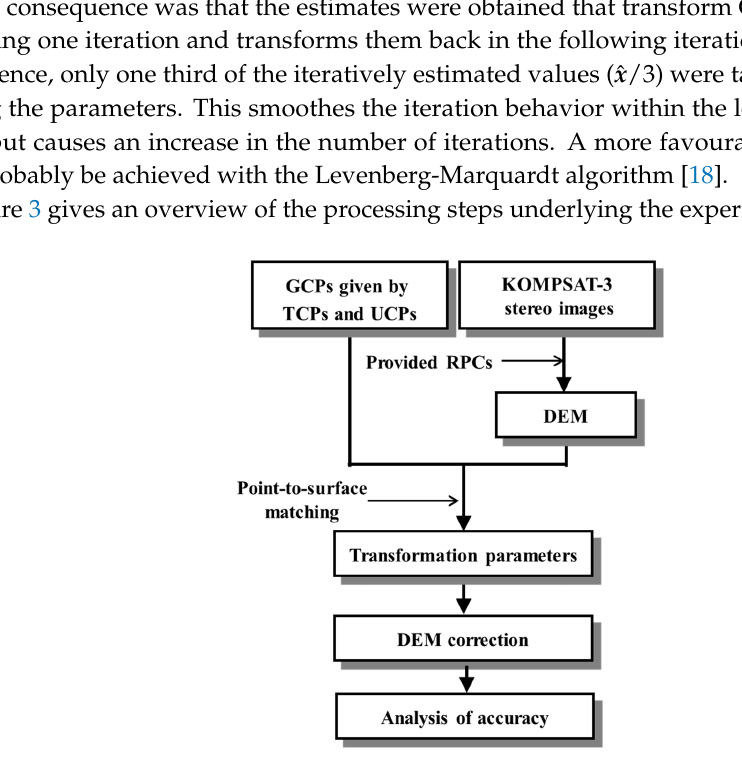
Figure 3. Flow chart for the correction of the DEM using point-to-surface matching.